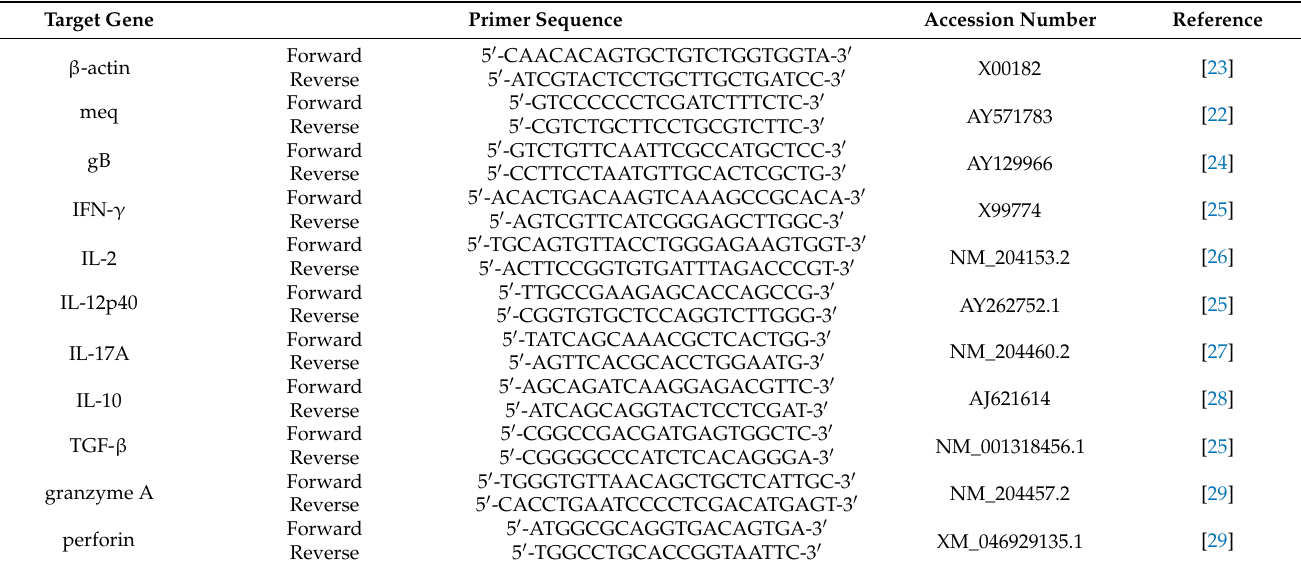
Table 2. Primer sequences for real-time PCR.